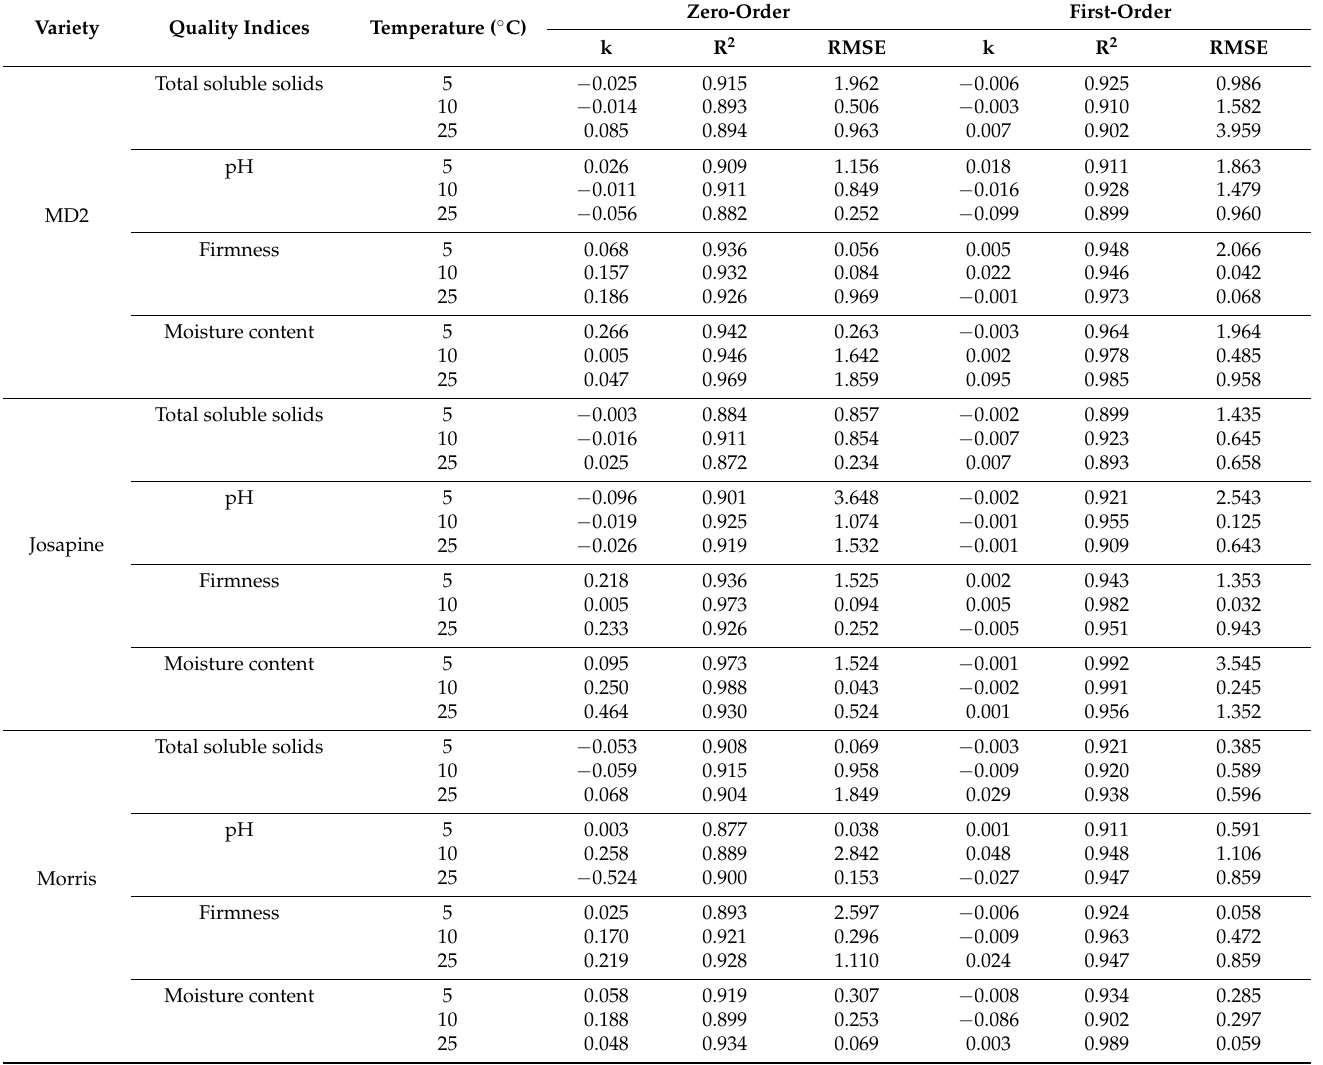
Table 3. Reaction order estimation for physicochemical properties of different pineapple varieties during